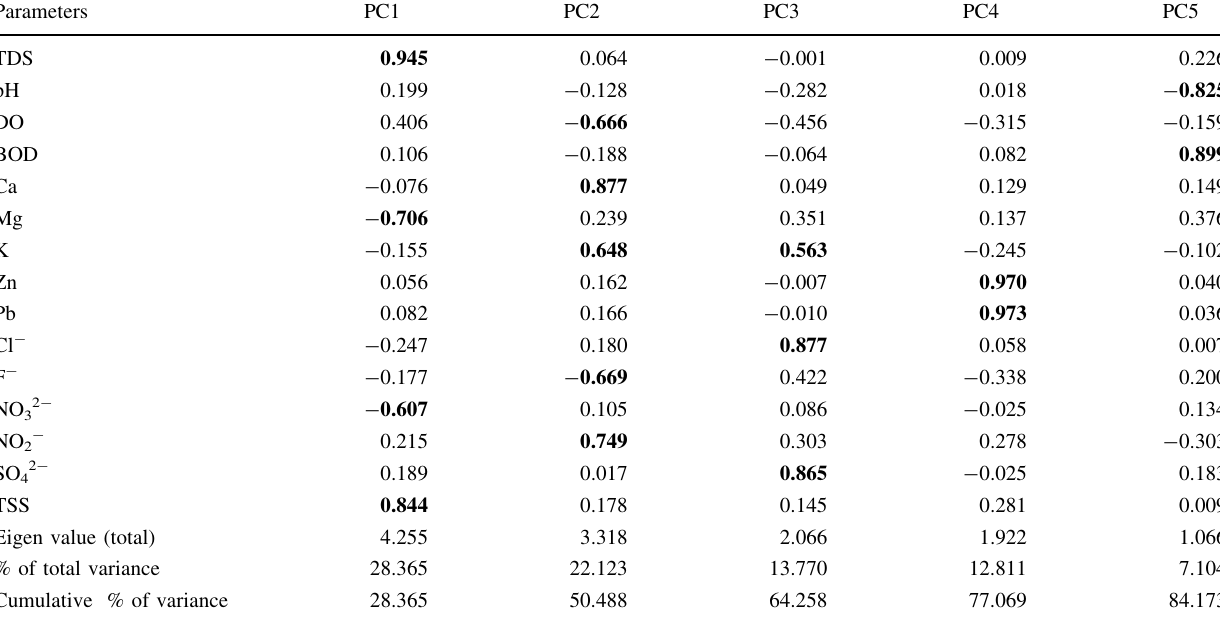
Table 3 Rotated component matrix of five factor model with moderate to strong loadings in bold typeface